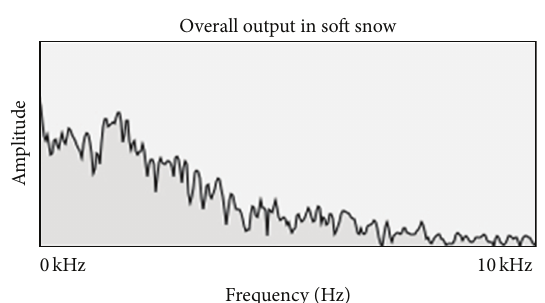
Figure 16: Spectrogram showing a snapshot of the overall output in very soft snow.